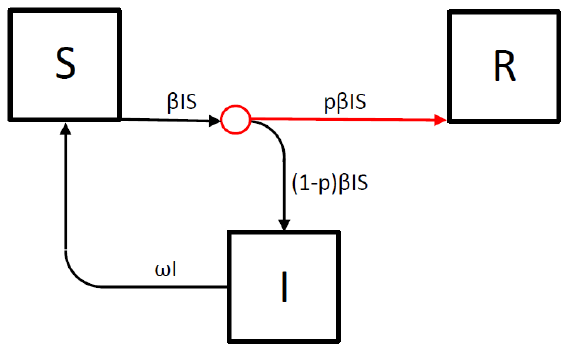
Figure 2. Two-component epidemic diagram. Here 𝑺 is the share of susceptible, 𝑰 is the share of asymptomatically infected, 𝑹 is the share of symptomatically infected + the share of those who recovered after the illness and got the long-term immunity. Model parameters: 𝝎 is the elimination rate, 𝜷 is the spread rate, 𝒑 is the relative probability of symptomatic infection, (𝟏 − 𝒑) is the relative probability of asymptomatic infection. The bifurcation point is shown with red circle. It is like the conventional SIR model and differs from it in the meaning of the variables. A distinctive feature of the two-component model is the bifurcation point, at which it is possible to choose between the symptomatic state (disease) and the asymptomatic state (latent infection). Another feature is the presence of a closed SIS cycle of re- infection with the participation of asymptomatic infected. The reason for the cycle is the absence of long-term immunity after asymptomatic infection. Neither of these two features exist in the conventional SIR model, which ignores the possibility of asymptomatic